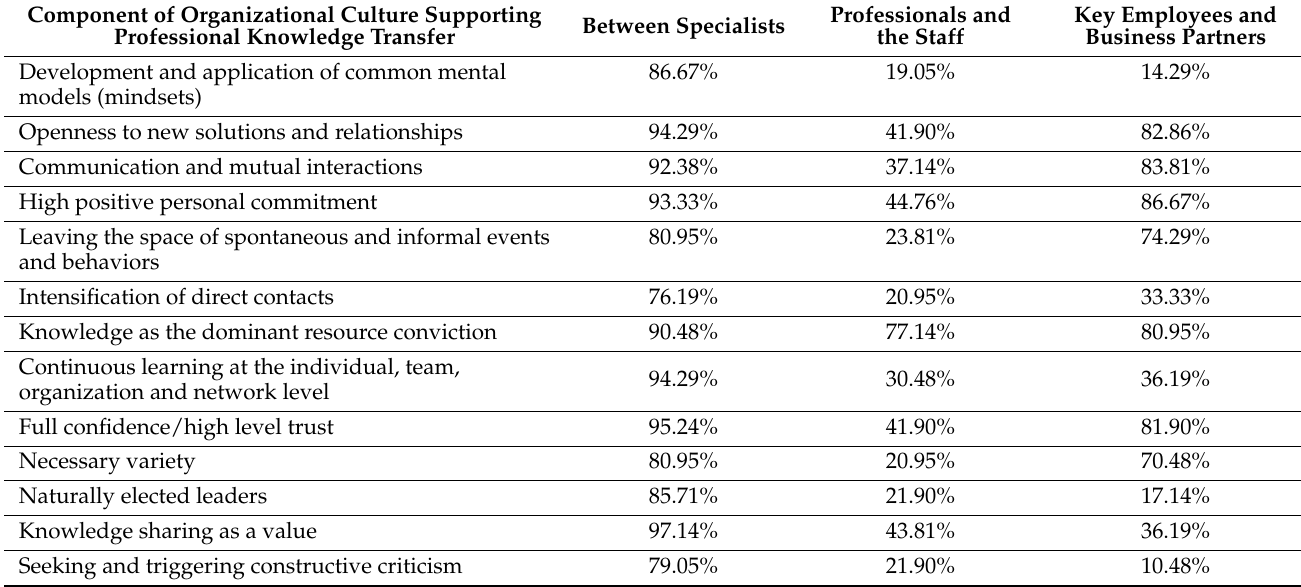
Table 4. Assessment of the importance of the components constituting the organizational culture oriented on circulating specialist knowledge in various groups of knowledge exchange agents. Component of Organizational Culture Supporting Between Professional Knowledge Transfer